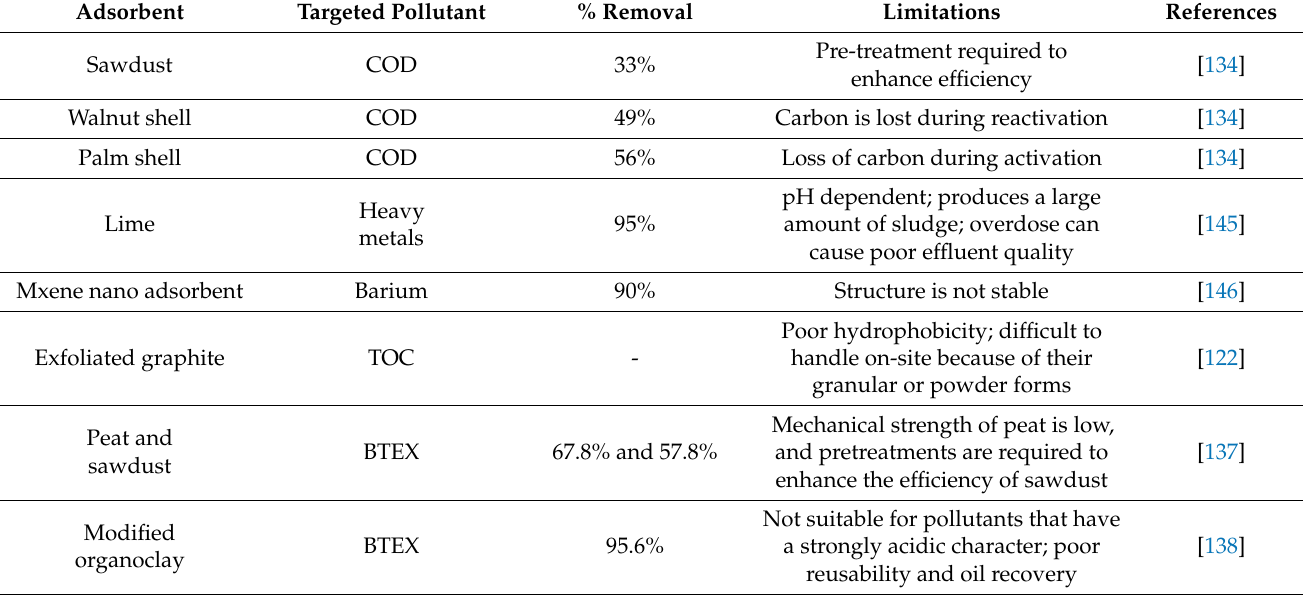
Table 4. Different types of adsorbent used for produced water